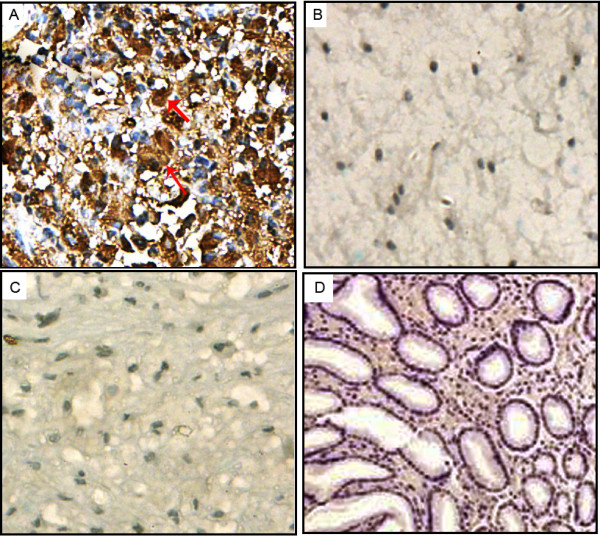
Representative photographs for CLIC1 immunostaings in glioma tissues with WHO grade IV (A, Original magnification×400) and nonneoplastic brain tissues (B, Original magnification×400). In glioma tissues, the immunostaining of CLIC1 was mainly expressed in the cytoplasm of tumor cells with brown yellow (marked by arrows). In contrast, Negative immunostaining was shown in the non-neoplastic brain tissues. Additionally, CLIC1 was not present in negative controls with non-immune IgG (Figure 1C, Original magnification×400) and in normal gastric tissues (Figure 1D, Original magnification×200).